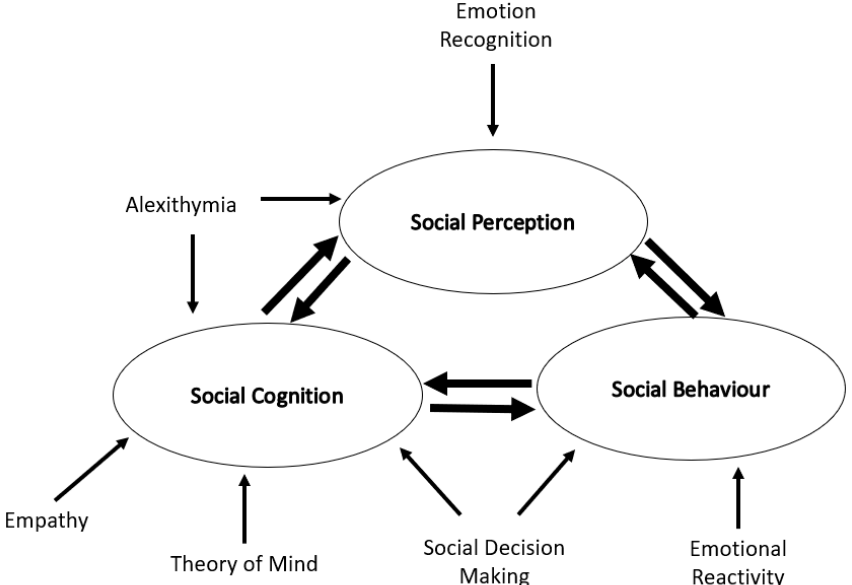
Figure 1. Social cognition in Huntington’s disease. A schematic representation of the social cognitive processes involved in Huntington’s disease and their relationship to one another.